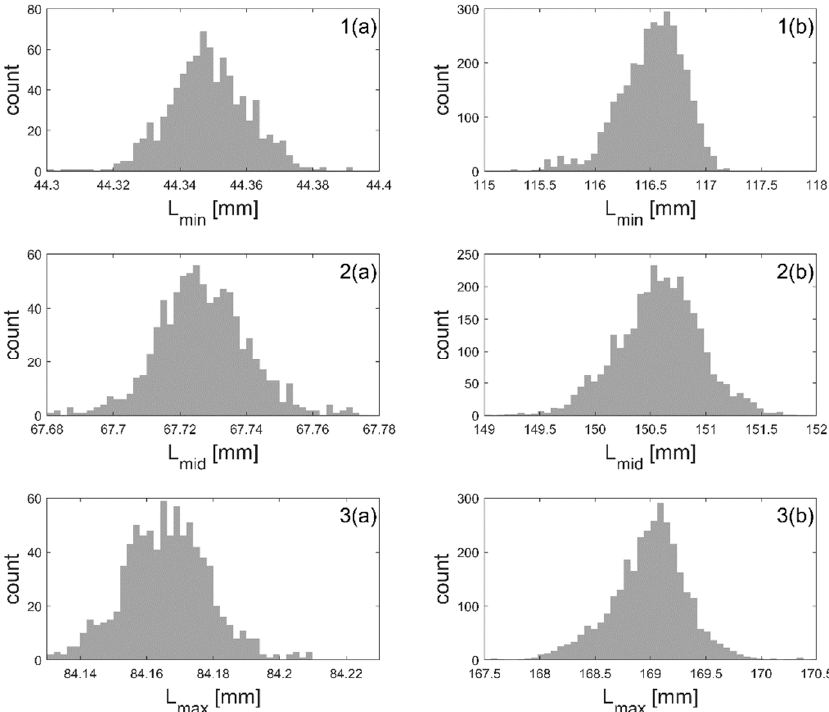
Figure 2. Histograms of the distances between the three markers measured in Experiment 1 by the laser tracker (left column) and the motion capture system (right column).